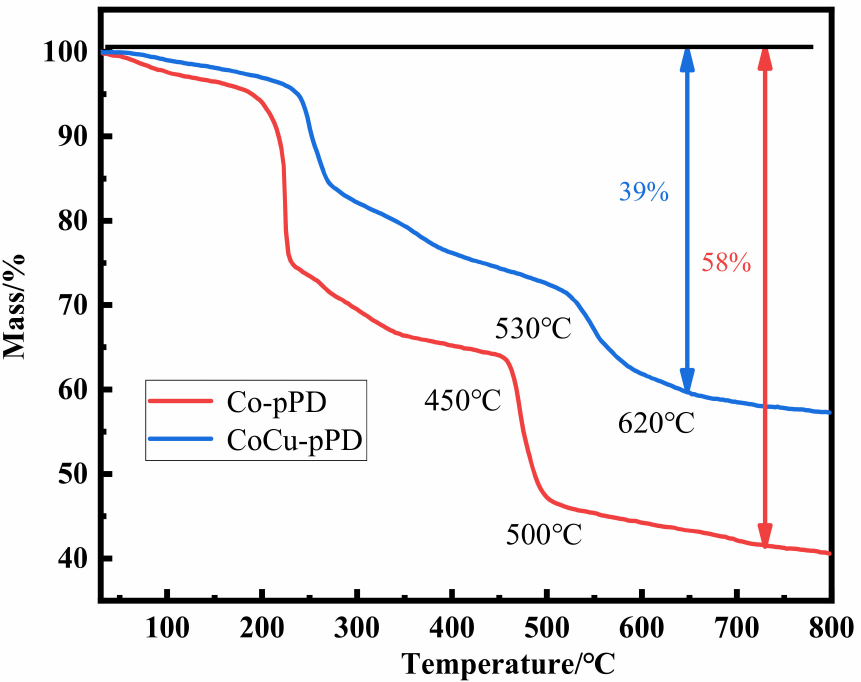
Figure 3. TG curves of Co-pPD and